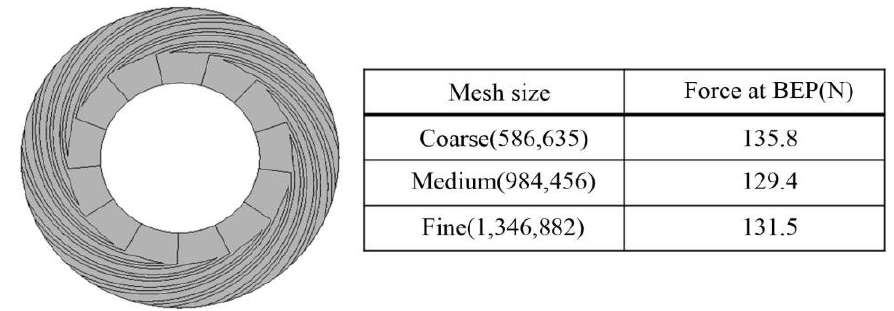
Figure 4. Mesh of flow path in the thrust bearing and mesh independence study.